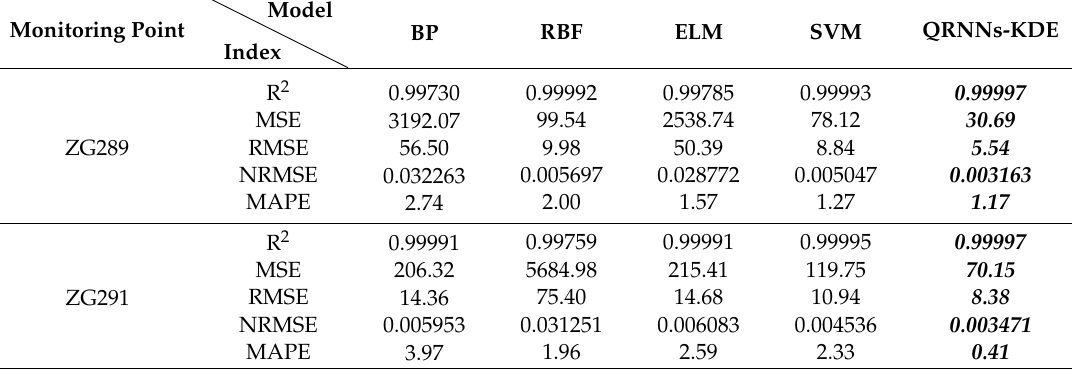
Table 2. Comparisons of predictions obtained from QRNNs-KDE, BP, RBF, ELM, and SVM for the Fanjiaping landslide.